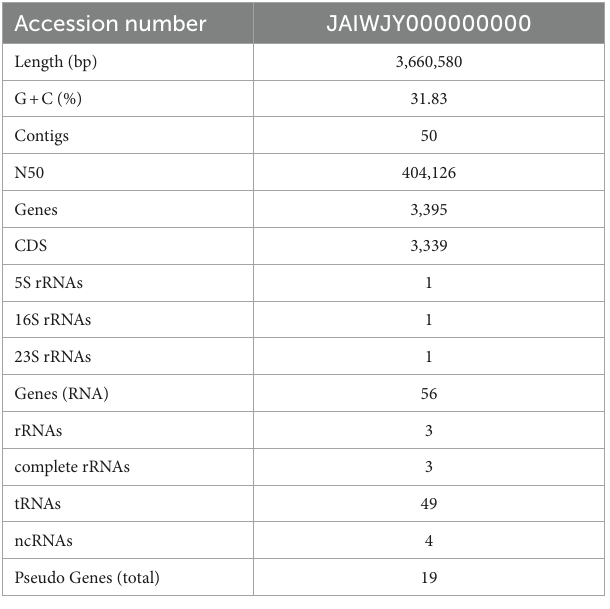
TABLE 3 General genomic characteristics of Tenacibaculum sp. strain LAR25.